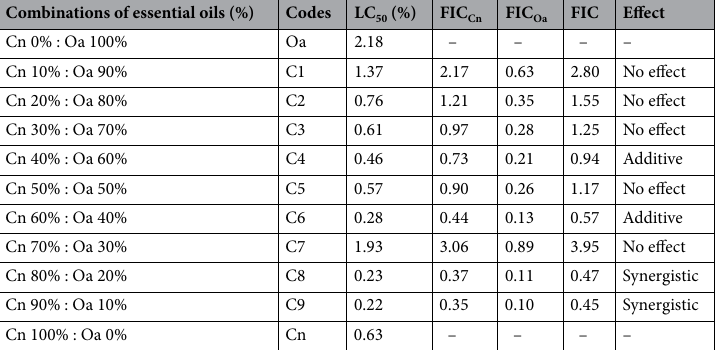
Combinations of essential oils